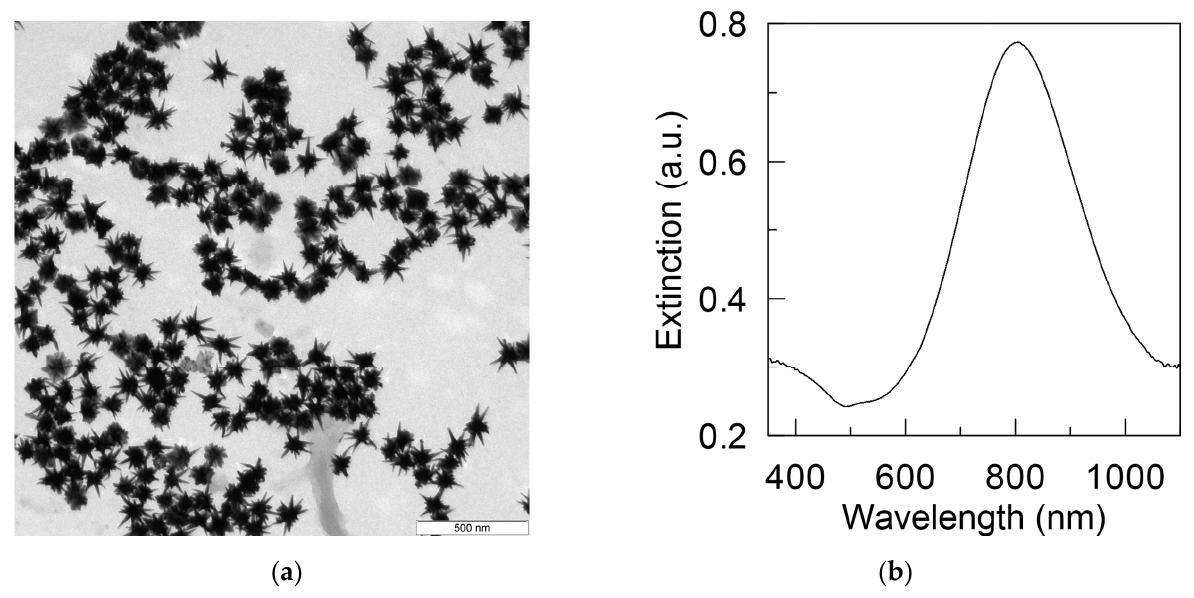
Figure 2. TEM image ( a ) and extinction spectrum ( b ) of synthesized GNS suspended in